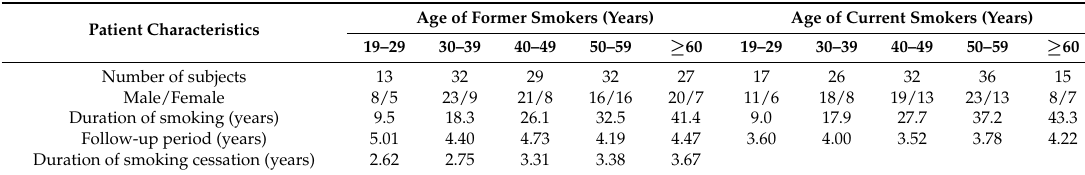
Table 2. Demographic characteristics of the